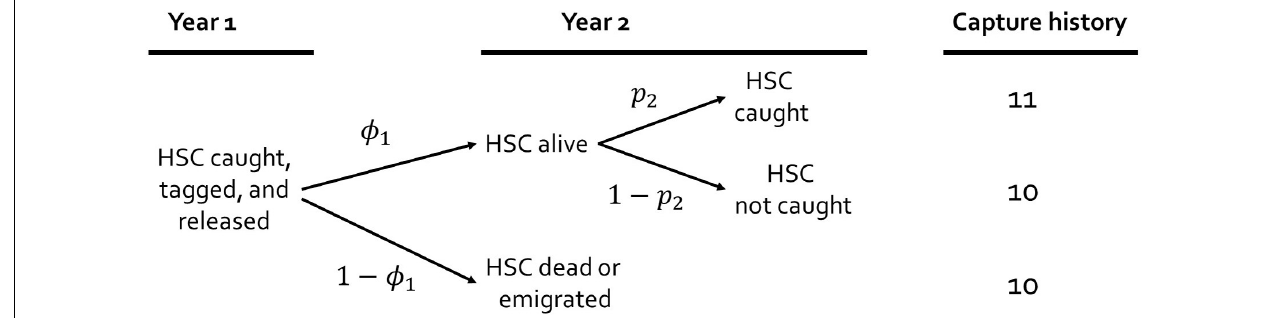
FIGURE 2 | Diagram illustrating the capture-recapture sampling process over two years. The parameters represent the apparent survival ( ϕ ) and capture probabilities (p). The capture histories represent capture by ‘1’ and not capture by ‘0.’